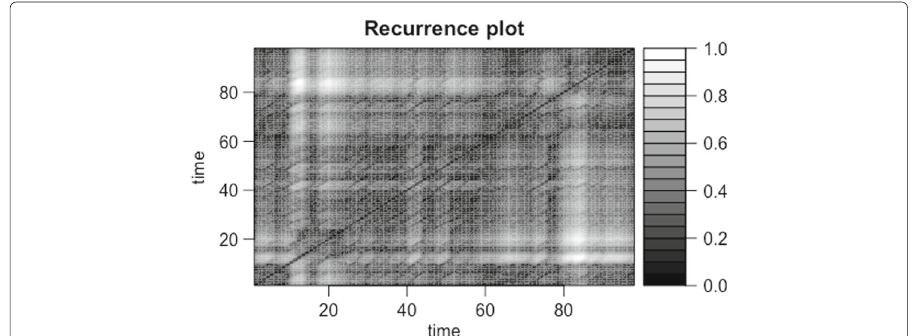
Fig. 2 Recurrence Plots. The figure shows the recurrence plots of the HR time series for a patient.The parameters used for the recurrence plots were (d=2 and m=3, where m is the embedding dimension and d is the delay)